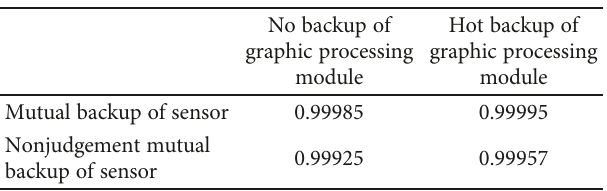
Table 4: Availability for di ff erent architectures of bilateral tolerant display function under the steady states.